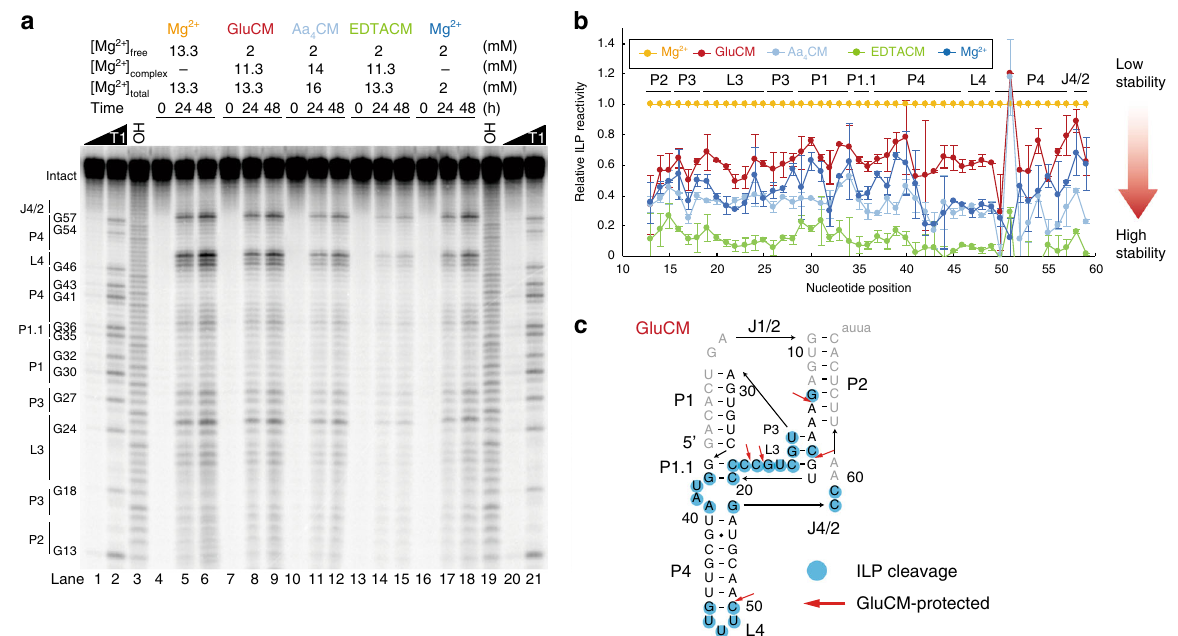
Fig. 3 Amino acid-chelated magnesium reduces RNA degradation according to ILP reactivities. a ILP on the drz-spur-3 ribozyme. Lane 1 – 2 and 20 – 21 are RNase T1 ladders (G). Lane 3 and 19 are alkaline hydrolysis ladders (OH – ). Lane 4 – 6 are time-dependent ILPs in the presence of 13.3 mM Mg 2 + total . Lane 7 – 9 are that in the presence of 96 mM glutamate and 13.3 mM Mg 2 + total (2 mM Mg 2 + free ). Lane 10 – 12 are that in the presence of 106 mM amino acids and 16 mM Mg 2 + total (2 mM Mg 2 + free ). Lane 13 – 15 are that in the presence of 11.3 mM EDTA and 13.3 mM Mg 2 + total (2 mM Mg 2 + free ). Lane 16 – 18 are that in the presence of 2 mM Mg 2 + total for a control. Concentrations of binding donors are the same as in Fig. 1. b Relative ILP reactivity at 24 h at each nucleotide position is shown. The relative reactivity in high Mg 2 + condition was set at 1.0. The error bars show average errors ( n = 2). c ILP reactivity in the presence of 13.3 mM Mg 2 + referenced to U49. Nucleotides colored in blue show the positions where ILP reactivity is greater than 7.5% of U49. Red arrows